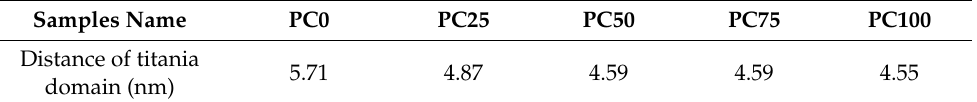
Figure 2. ( a ) Photographs of each polycarbonate/titania hybrid film. ( b ) UV-vis spectra of each polycarbonate/titania hybrid film: PC100 (black line), PC75 (red line), PC50 (orange line), PC25 (green line) and PC0 (purple line). ( c ) Small angle X-ray scattering (SAXS) profile of polycarbonate/titania hybrid film: PC100 (black line), PC75 (red line), PC50 (orange line), PC25 (green line), and PC0 (purple line). Table 2. Distance between titania domains in each hybrid polymer obtained by SAXS